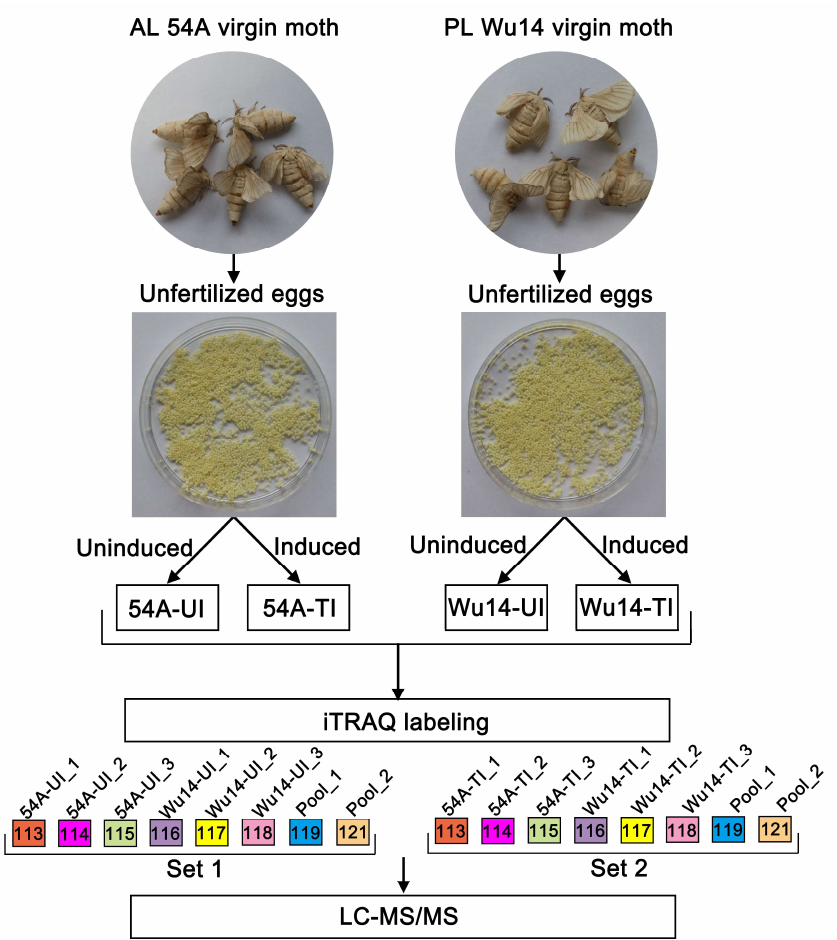
Figure 1. A schematic workflow of iTRAQ-based quantitative proteomics used in this study.